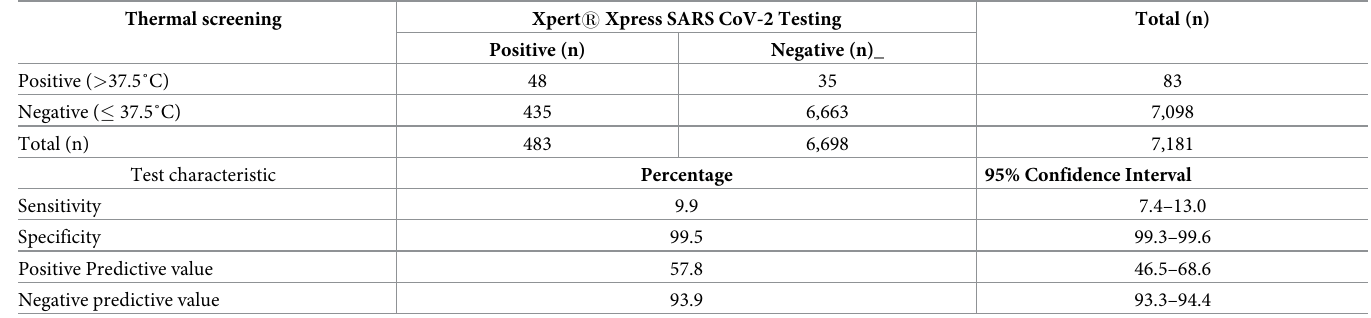
Table 2. Contingency table showing results of diagnostic accuracy of thermal screening. Thermal